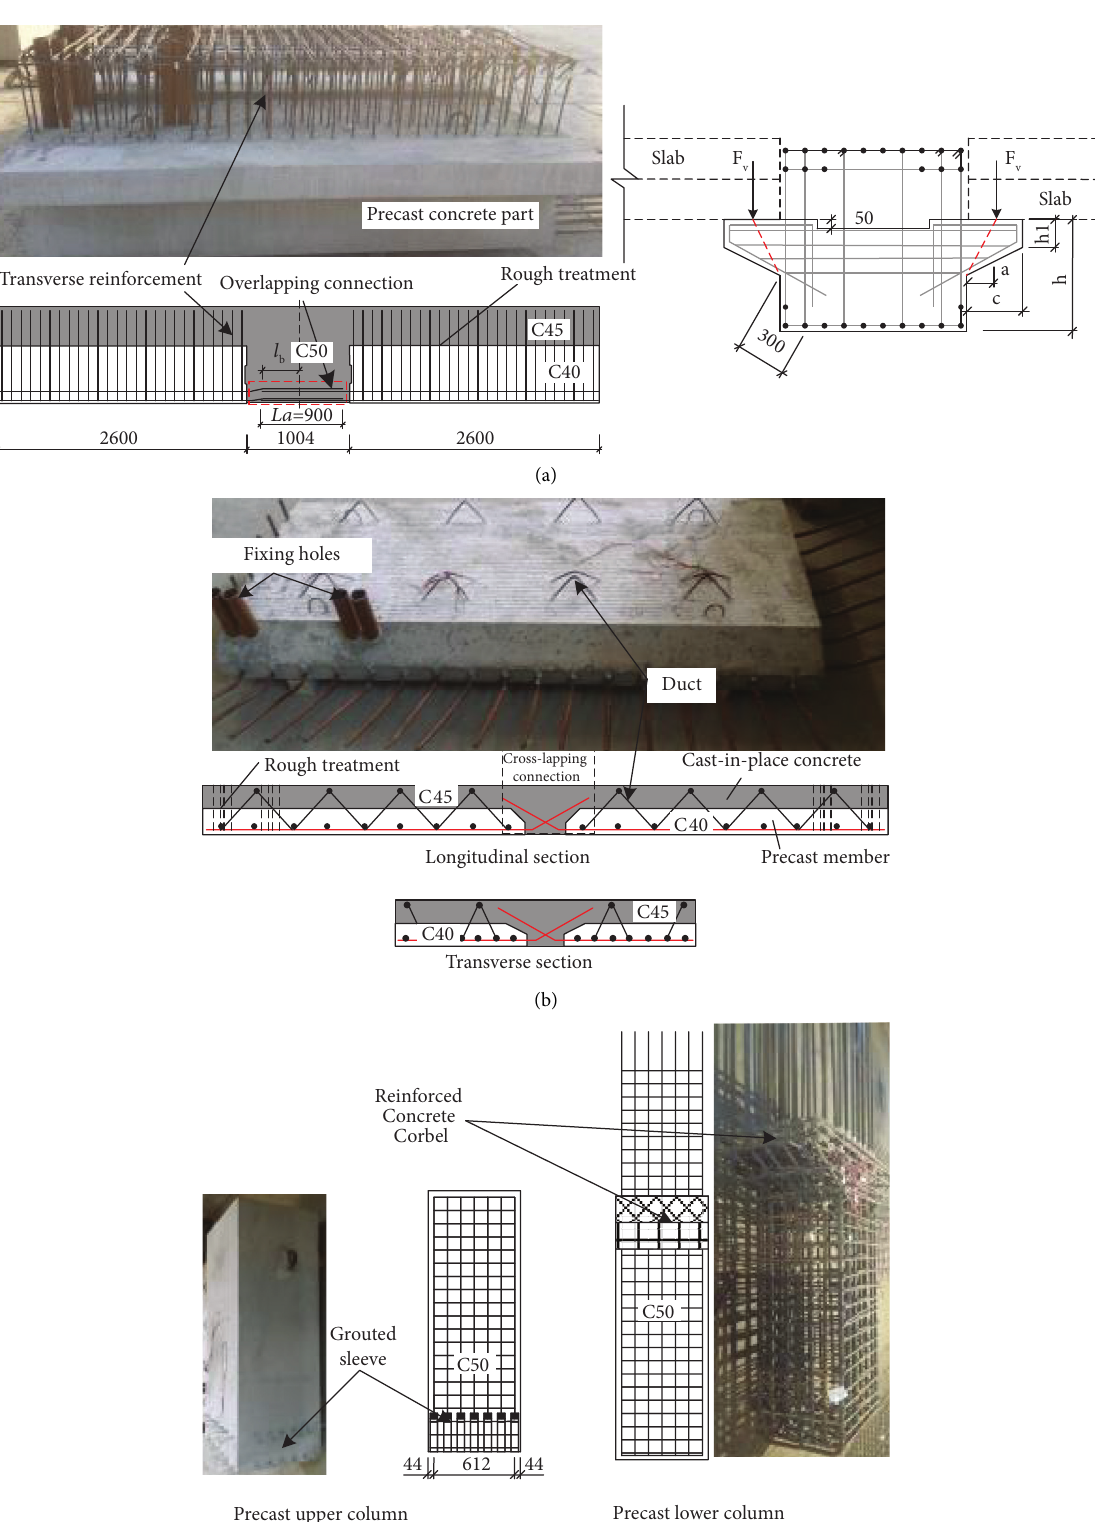
Figure 2: Connection structure of each member (unit: mm): (a) precast beam connection, (b) precast slab connection, and (c) precast column